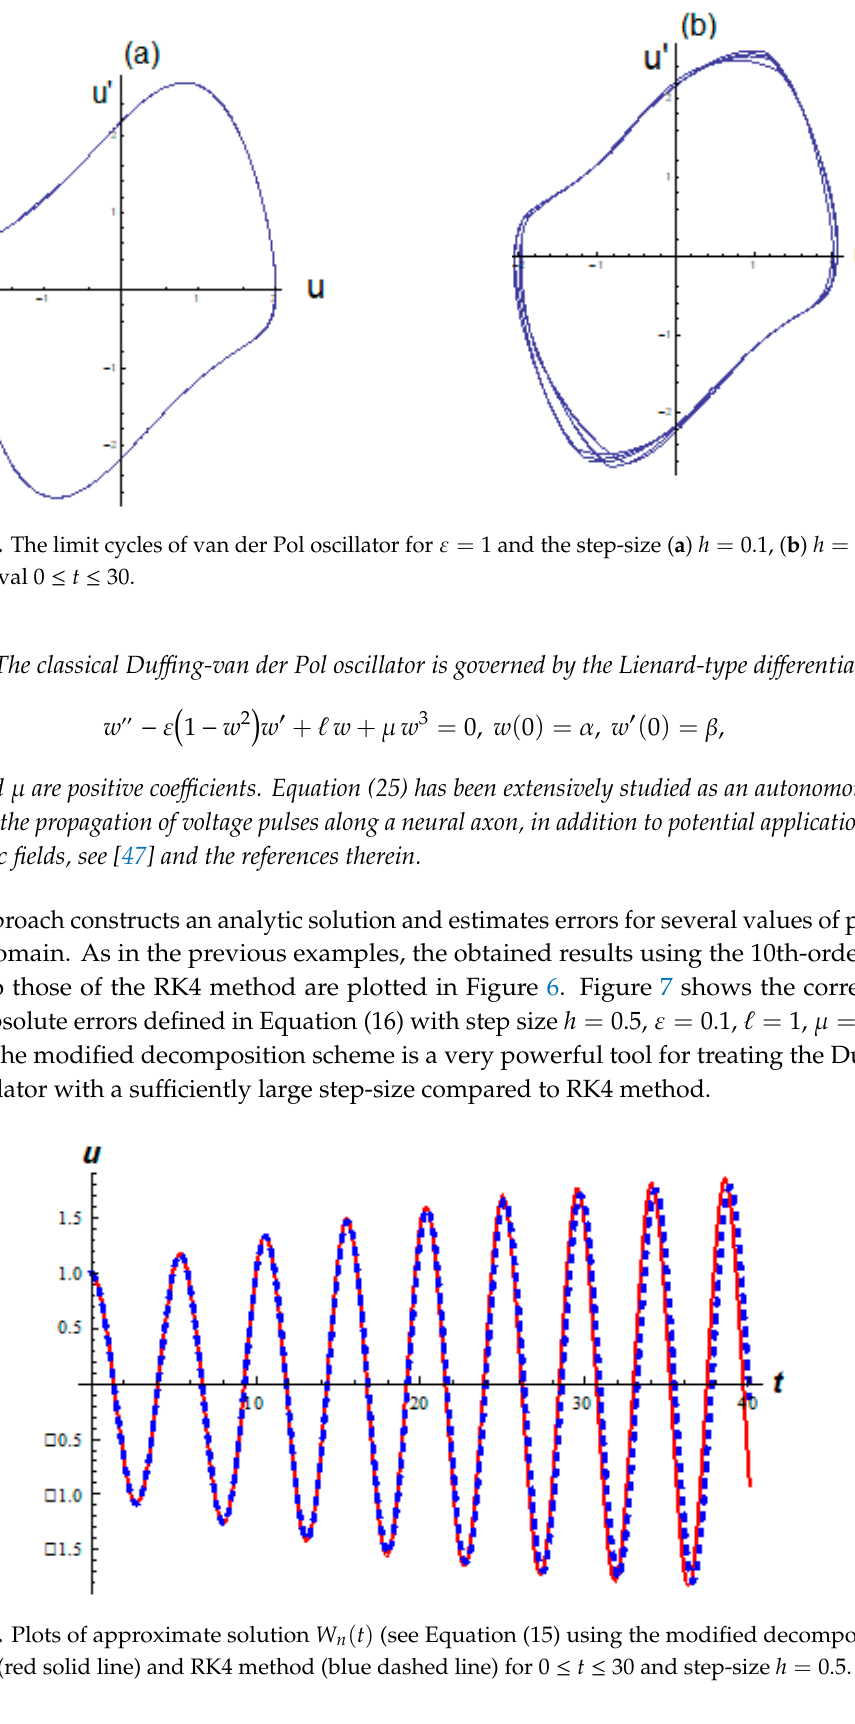
and RK4 method (blue line) for 0 30 t ≤ ≤ and step-size 0.1 h = .